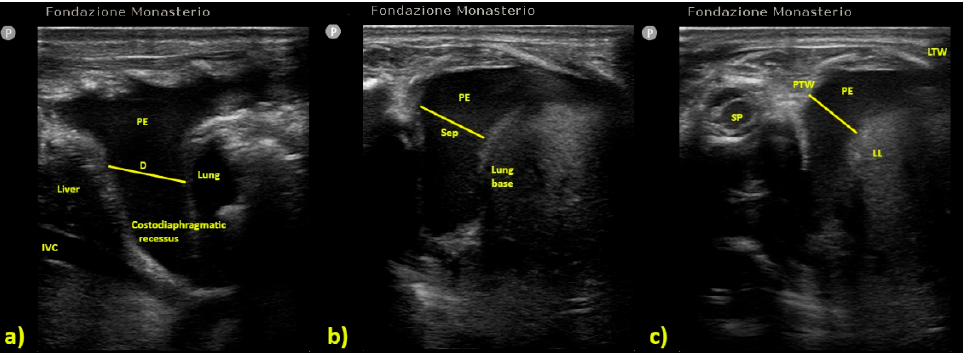
Figure 3. Formulas for pleural effusion quantification according to different authors: ( a ) Usta et al. [24], PEV is calculated by the formula D (mm) × 16, ( b ) Balik et al. [23] PEV is calculated by the formula Sep (mm) × 20; ( c ) Eibenberger [25] the major effusion’s diameter (D) is associated with PEV on a progressive scale (e.g., 10 mm correspond to 50–300 mL of PEV, 20 mm to 150–310 mL, etc.). (Table 2) D = distance; IVC = Inferior Vena Cava; LL = Lung Lower Lobe; LTW = Lateral Thoracic Wall; PE = Pleural Effusion; PEV = Pleural Effusion Volume; PTW = Posterior Thoracic Wall; Sep = maximal distance between parietal and visceral pleura; SP = Spine.